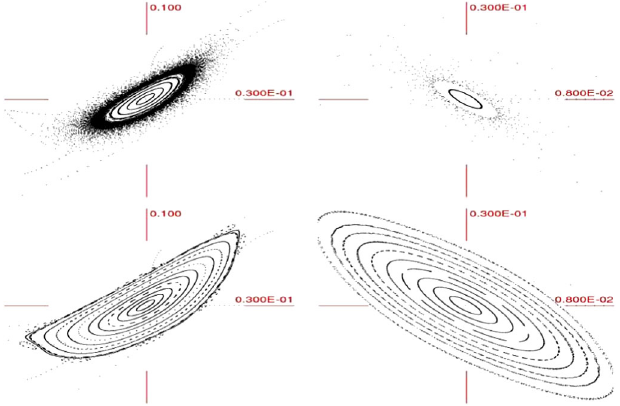
FIG. 2. Beam dynamicapertures (horizontal — left,andvertical — right) calculated with COSY INFINITY for a nonscaling sixfold symmetric FFAG with third-order out of plane expansion, without (top) and with (bottom) symplectification method